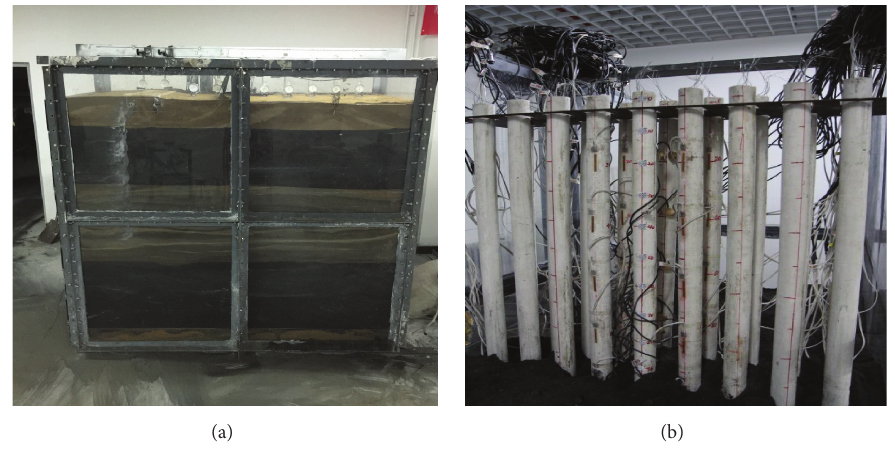
Figure 1: (a) Test model box and (b) the model double-row piles.